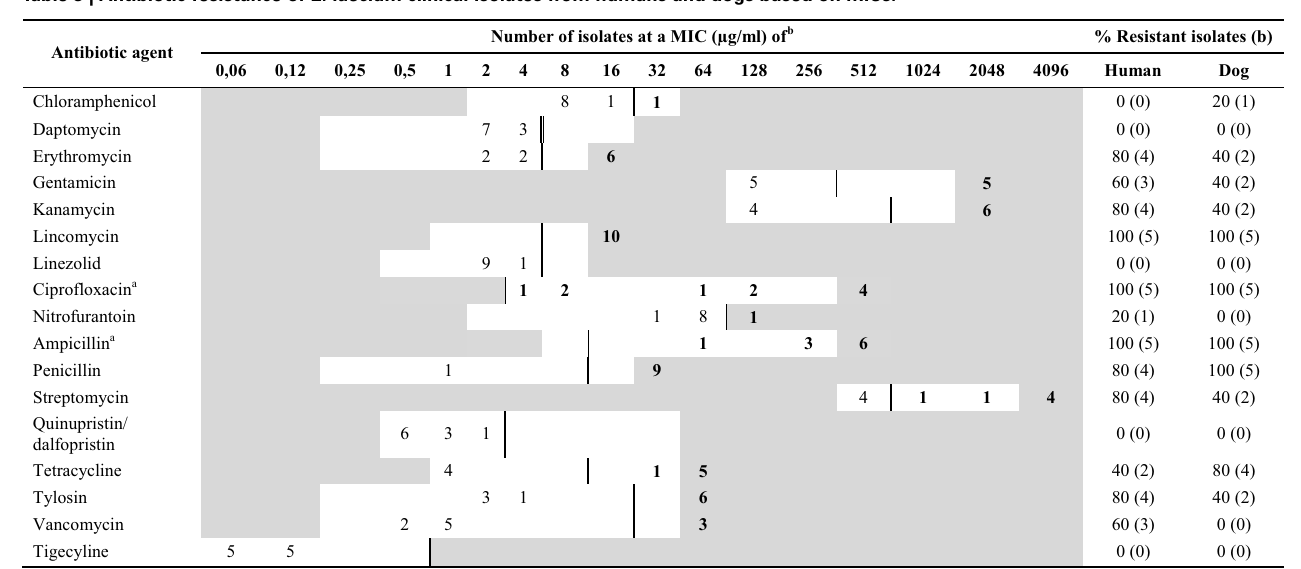
Table 1 . Results demonstrated all canine ARE isolates were acm - positive but were negative for esp and hyl genes. The majority of these isolates were shown to harbor efaA fm gene, encoding for a cell wall adhesin. One canine ARE isolate also had the agg gene encoding for an aggregation substance of pheromone-responsive plasmid. The efaA fm gene was detected in all human isolates but one. The two human clinical isolates (CCRI-18707 and - 18231) were also positive for the glycosyl hydrolase gene ( hyl ). Acquisition of multiple antibiotic resistance genes was observed ranging from 2 to 14 per isolate. Correlation between MICs and the presence of resistance genes has indicated that tetracy- cline resistance was attributable to tet (M) ( n = 2); tet (M) and tet (L) ( n = 3); and tet (M), tet (L) and tet (O) ( n = 2). Resistance to erythromycin, lincomycin and tylosin could be explained by the presence of msrC , erm (AM)/ erm (B) in all strains with the exception of one (07-5598). Streptomycin resistance was associated with the aadE gene in all strains except one (07- all strains except two (07-5598 and M2971-08) whereas gen-